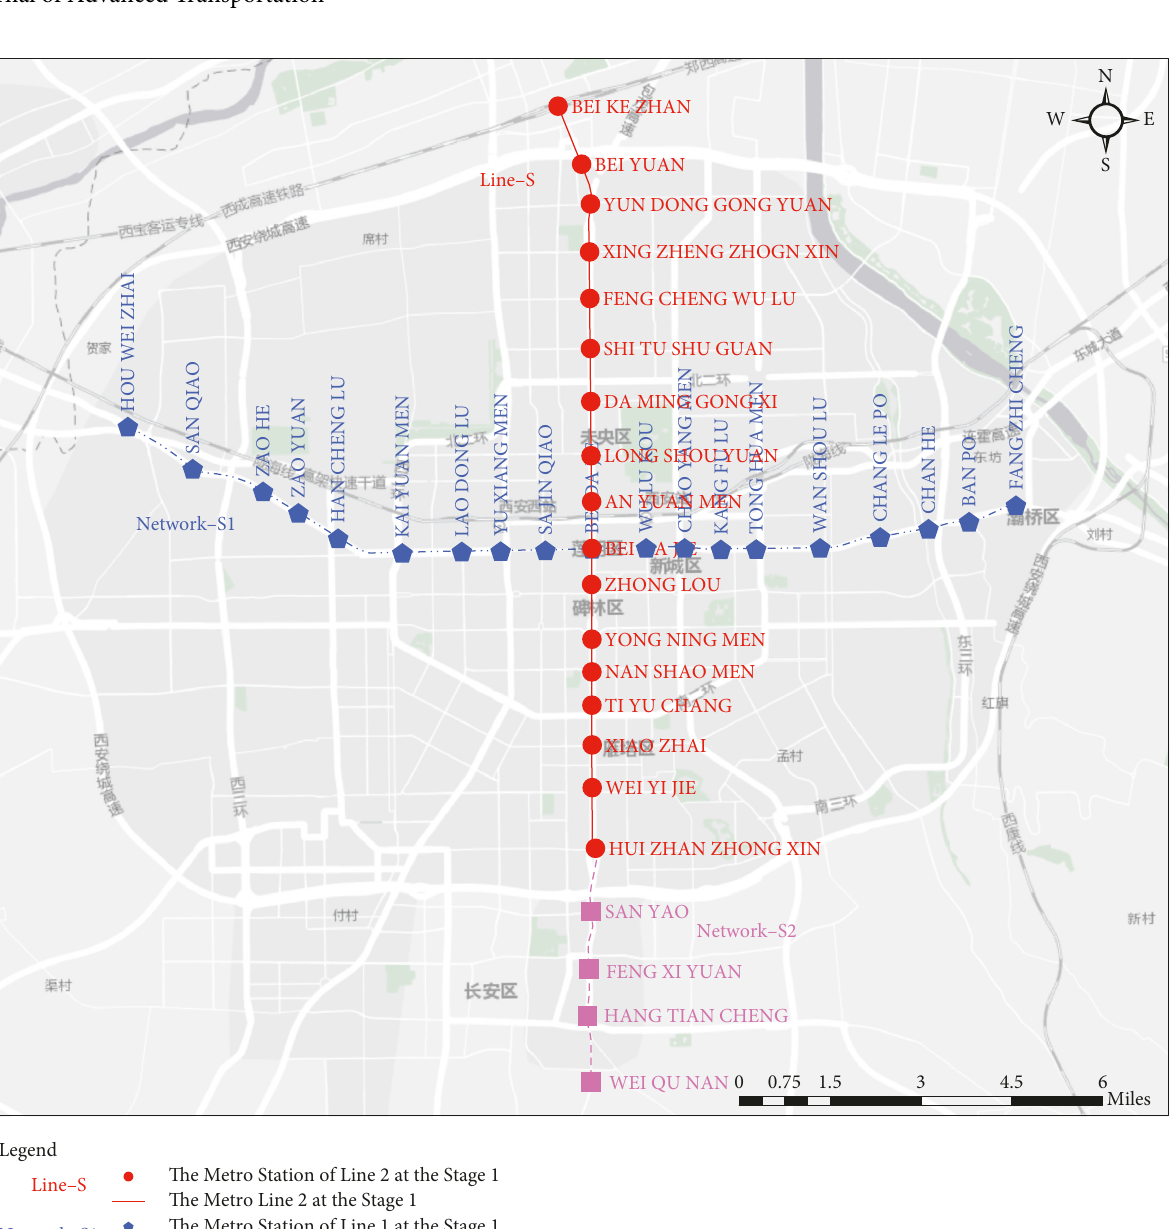
Figure 1: Map of the initial metro network in